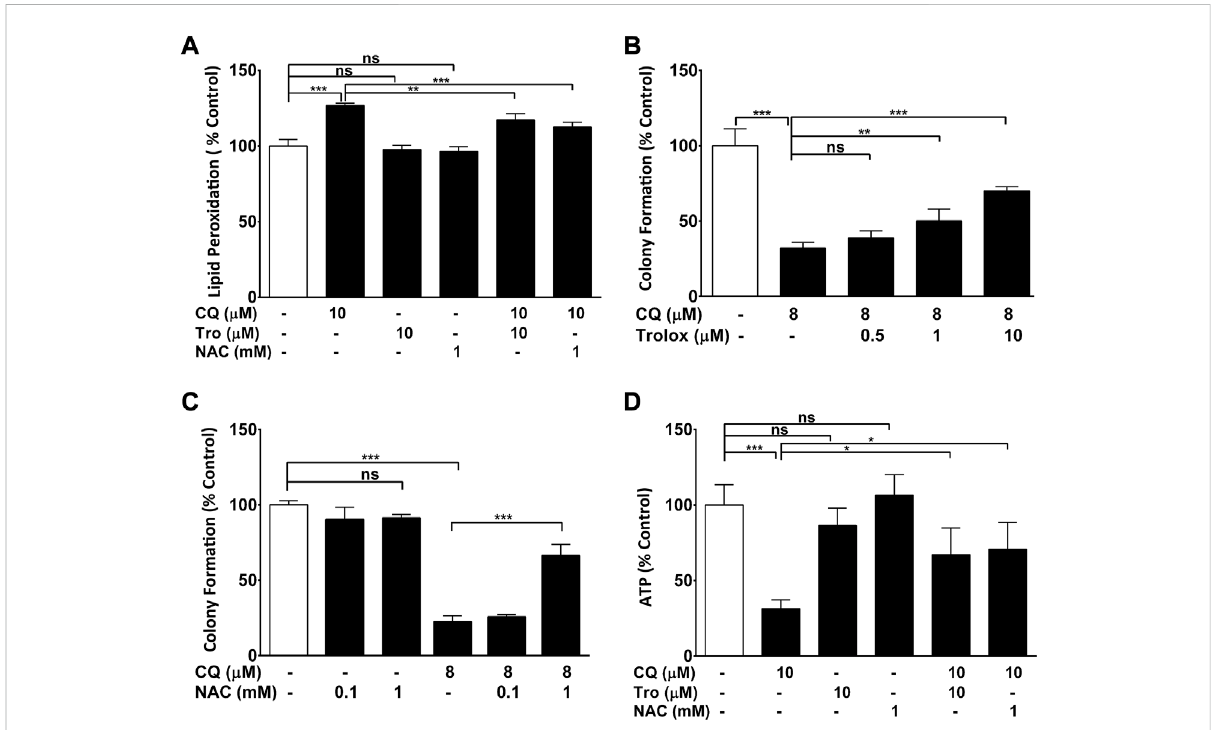
FIGURE 2 ROS-dependent clioquinol toxicity. (A ) Antioxidants ameliorate CQ-induced increase of lipid peroxidation. (A) HEK293-neo cells grown in low glucose were co-treated with antioxidants NAC (1 mM) or Trolox (10 μ M) and/or 10 μ M of CQ for 2 h before lipid peroxidation was measured using BODIPY-C 11 dye. (B, C) Antioxidants ameliorate CQ-induced reduction of cellular viability. HEK293 cells grown in low glucosewere treated with CQ and indicated concentrations of (B) Trolox or (C) NAC or before colony formation was assessed. (D) Antioxidants ameliorate CQ-induced reductionofcellularATPlevels. HEK293cellsgrowninglucosewereco-treatedwithantioxidantsNAC(1 mM)orTrolox(10 μ M)and/or10 μ MofCQ for 2 h before ATP levels were measured. Data represent the average of at least four individual samples per concentration of one experiment out